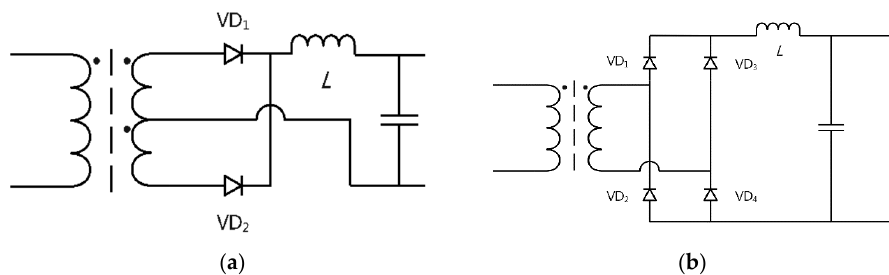
Figure 2. The main rectifier methods. ( a ) Center-tapped rectifier. ( b ) Bridge rectifier.